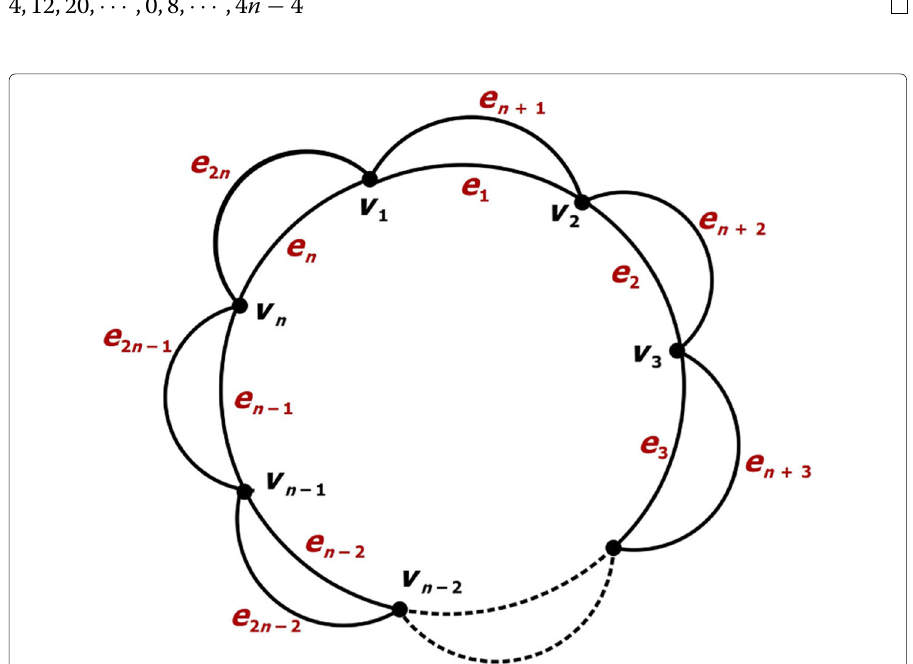
Fig. 17 { C n , n } with ordinary